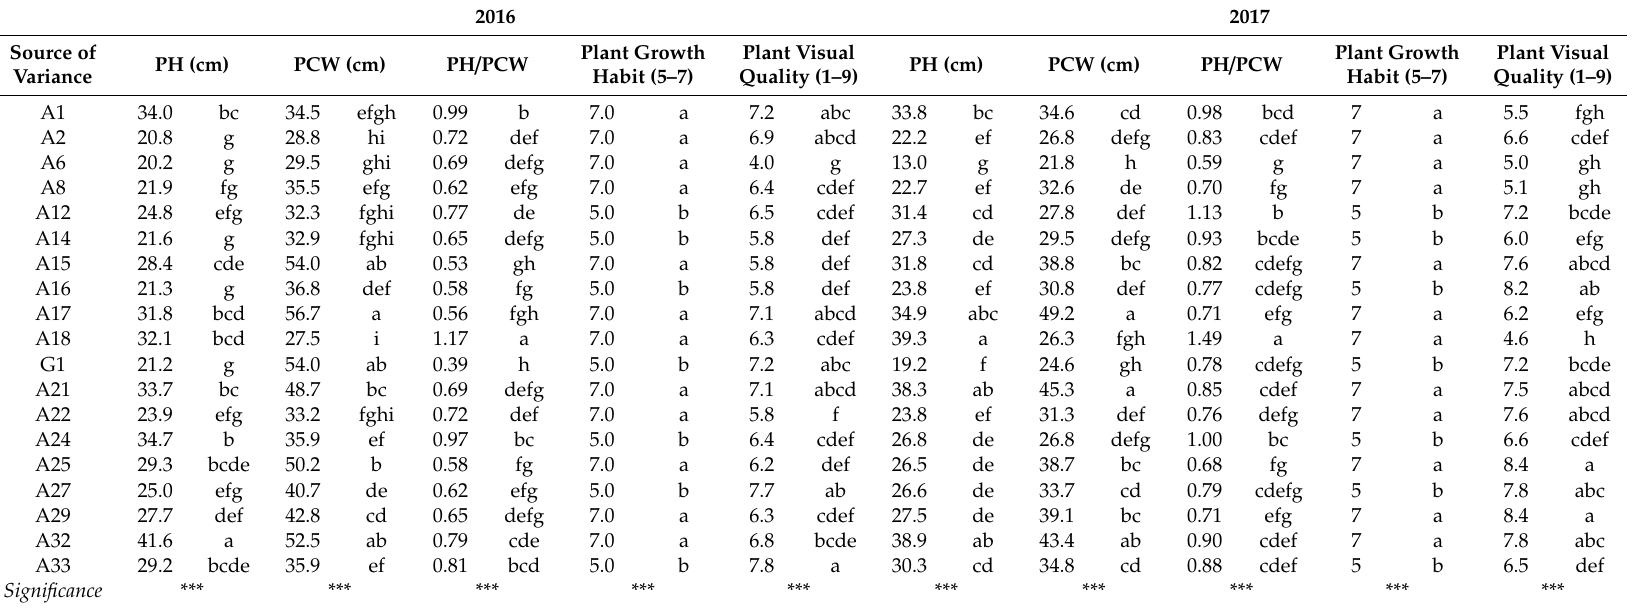
Table 1. E ff ect of 19 chili pepper accessions on plant height (PH), plant canopy width (PCW), PH / PCW ratio, plant growth habit and plant visual quality, in two years (2016 and